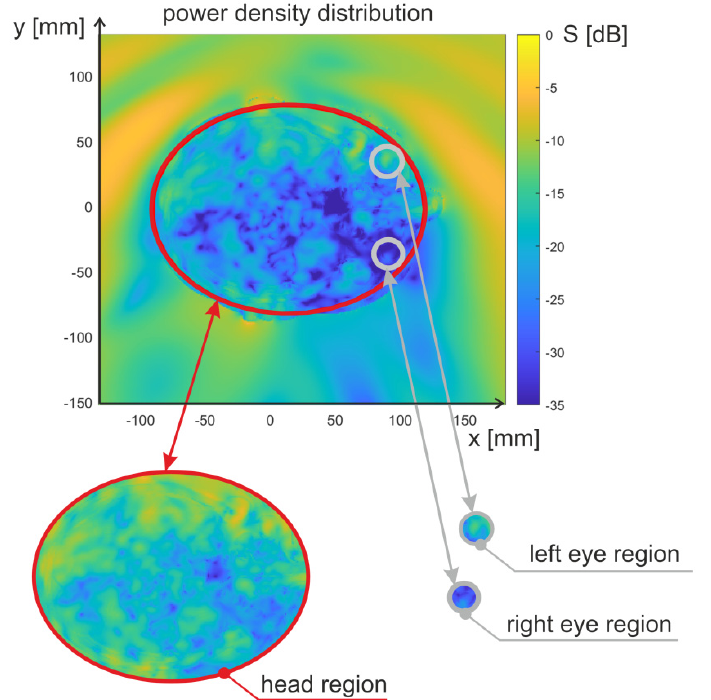
Figure 5. The head region and eye regions indicated in the power density distribution obtained from FDTD simulations.